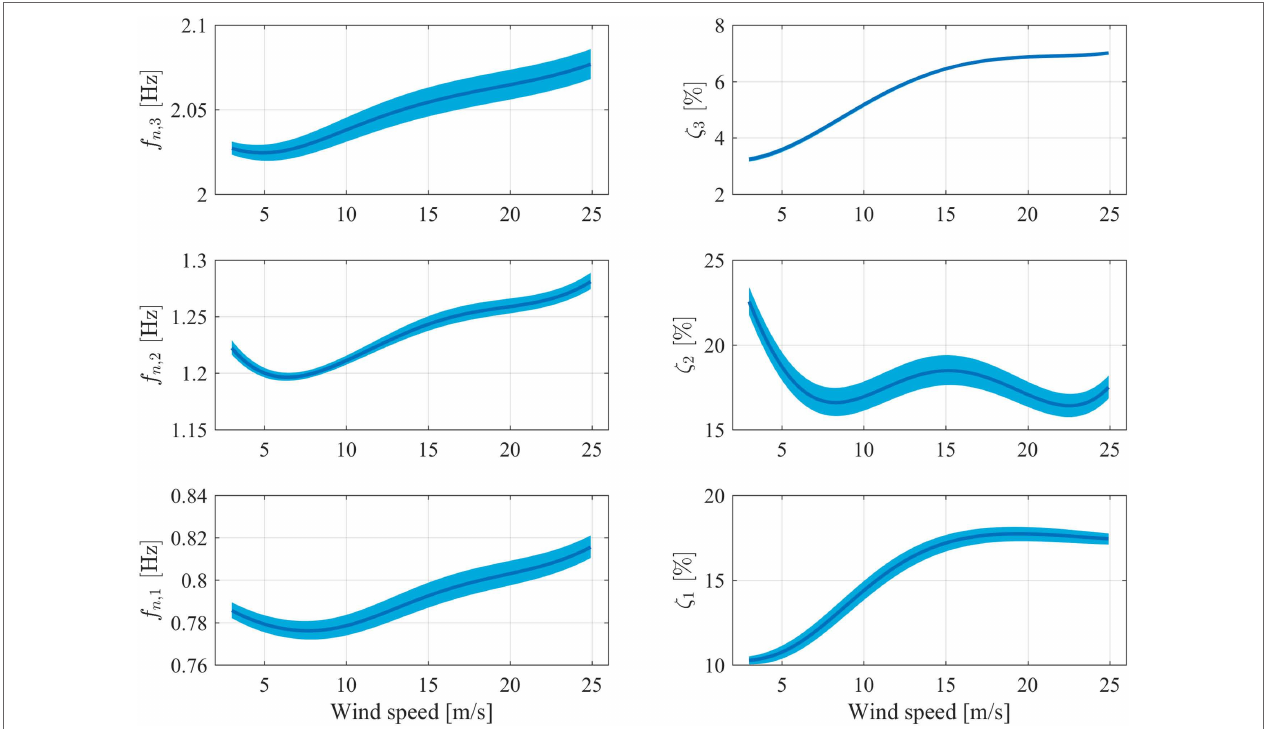
FIGURE 12 | GP-LPV-AR model-based average “frozen” natural frequencies and damping ratios of the wind turbine blade response evaluated for increasing wind speeds. Solid line indicates the average value, while shaded areas indicate estimates of the 95% confidence intervals.